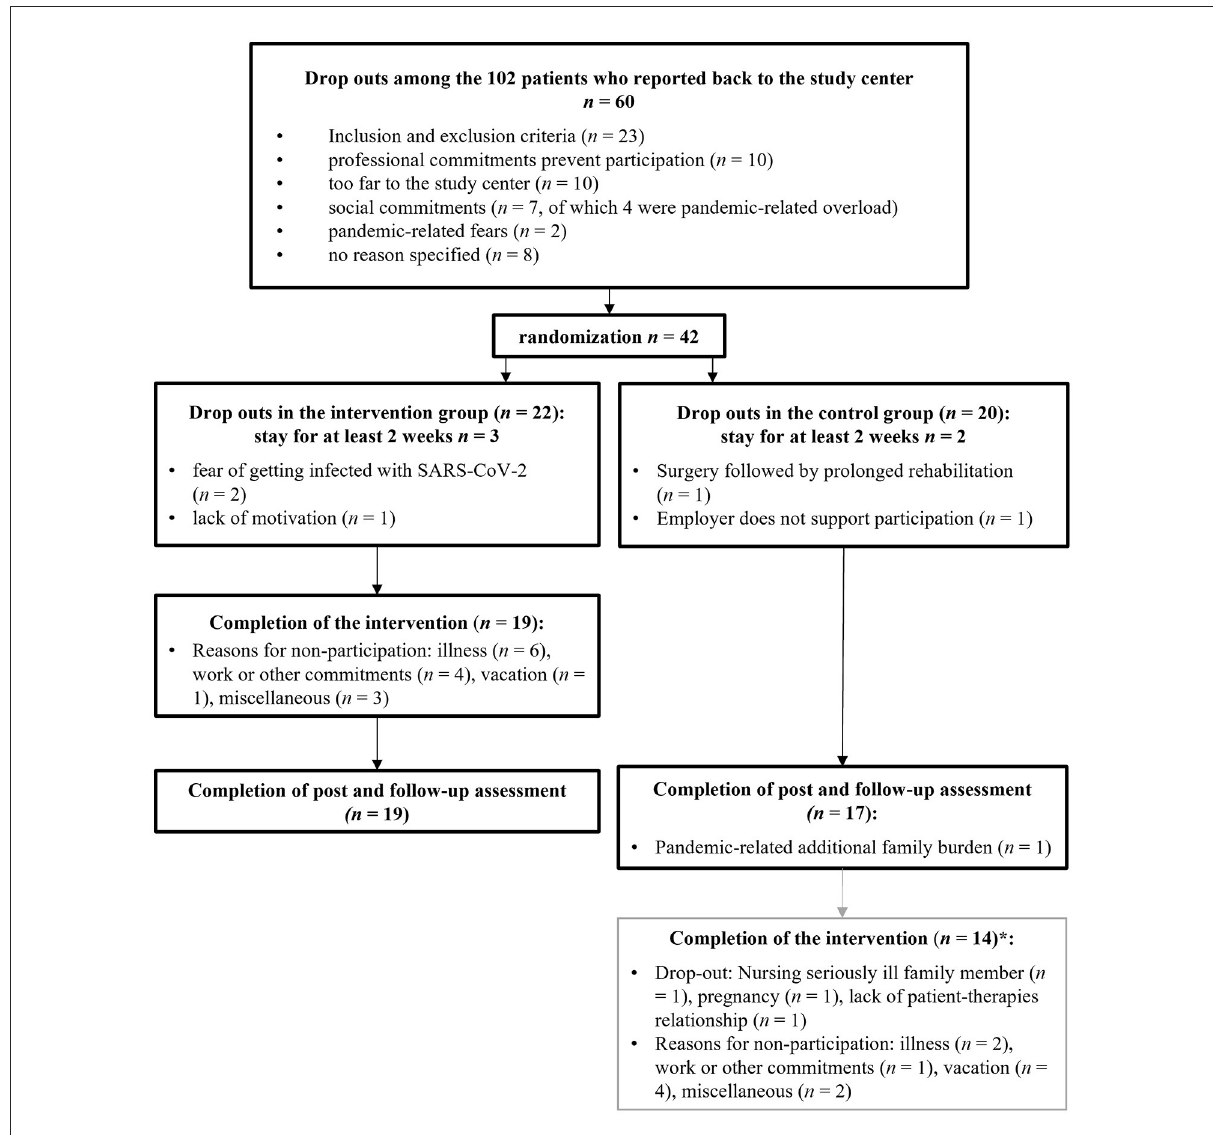
FIGURE3 Reasons for study discontinuation. *Completion of the intervention was not part of the initial study protocol.